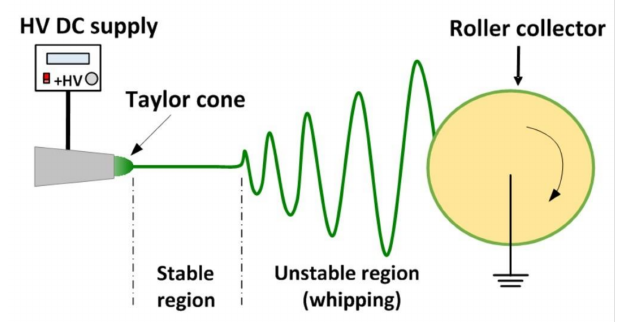
Figure 1. Schematic illustration of electrospinning system.